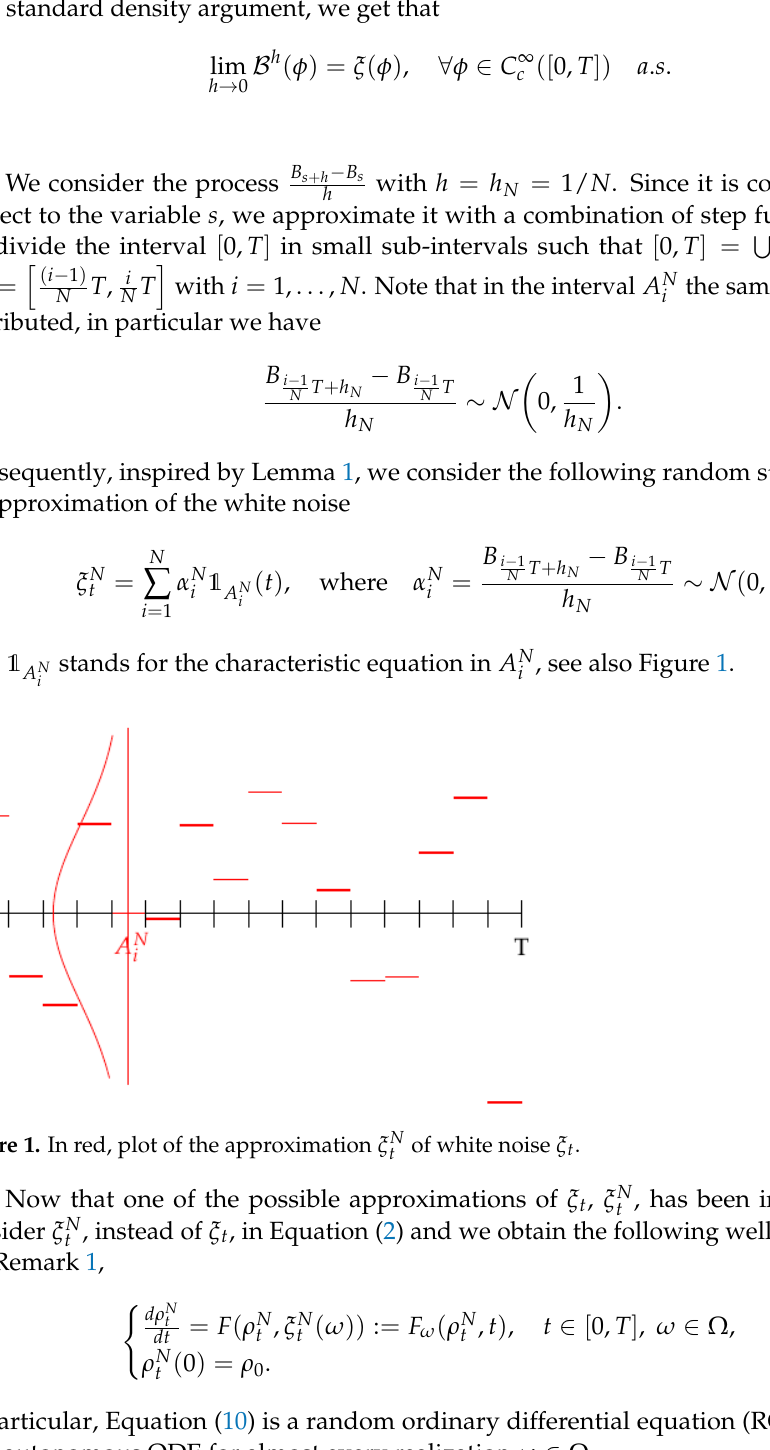
of white noise ξ t t